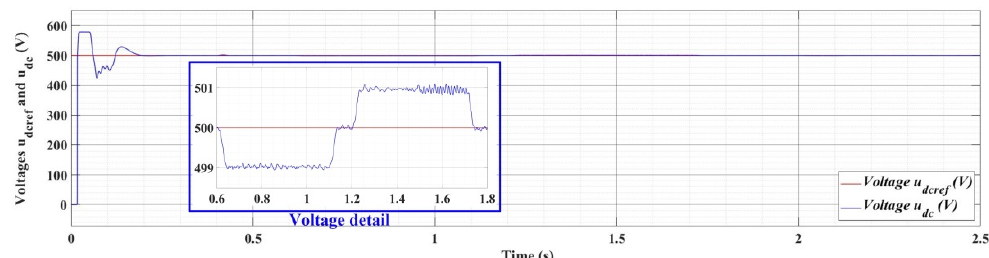
Figure 28. The time evolution of the u dc voltage for the irradiance and temperature using PI-type controllers (signal evolution of the type 1 PV array).